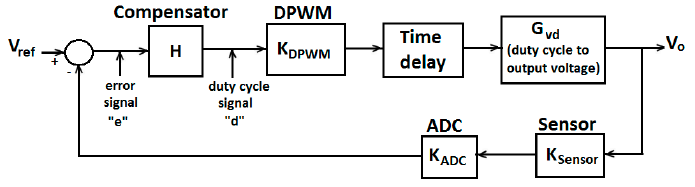
Figure 4. Buck converter control system point view.